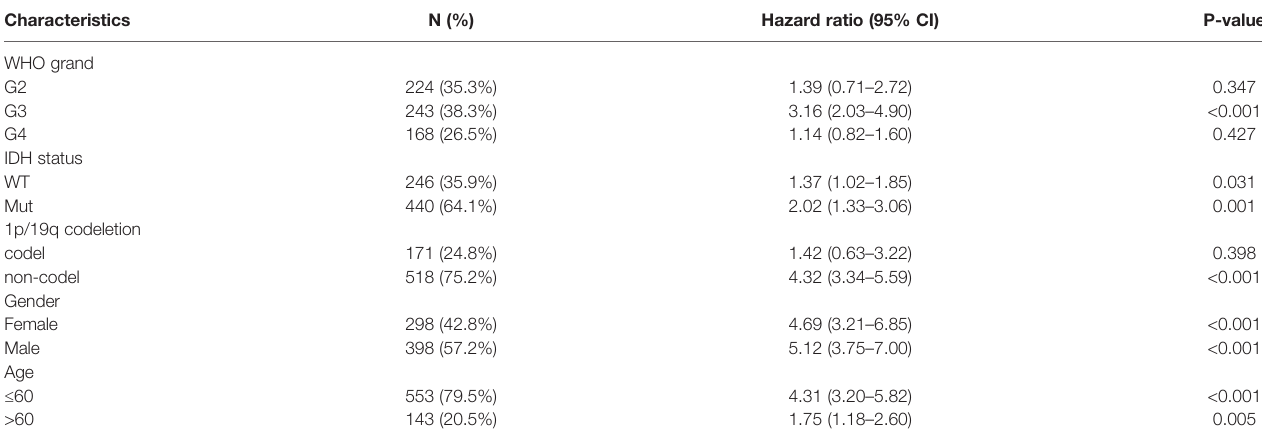
TABLE 4 | Prognostic analysis of ASF1B expression in a subset of patients with gliomas. Characteristics